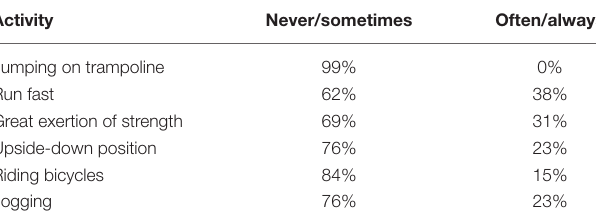
TABLE 2 | Frequency of symptoms during various activities according to